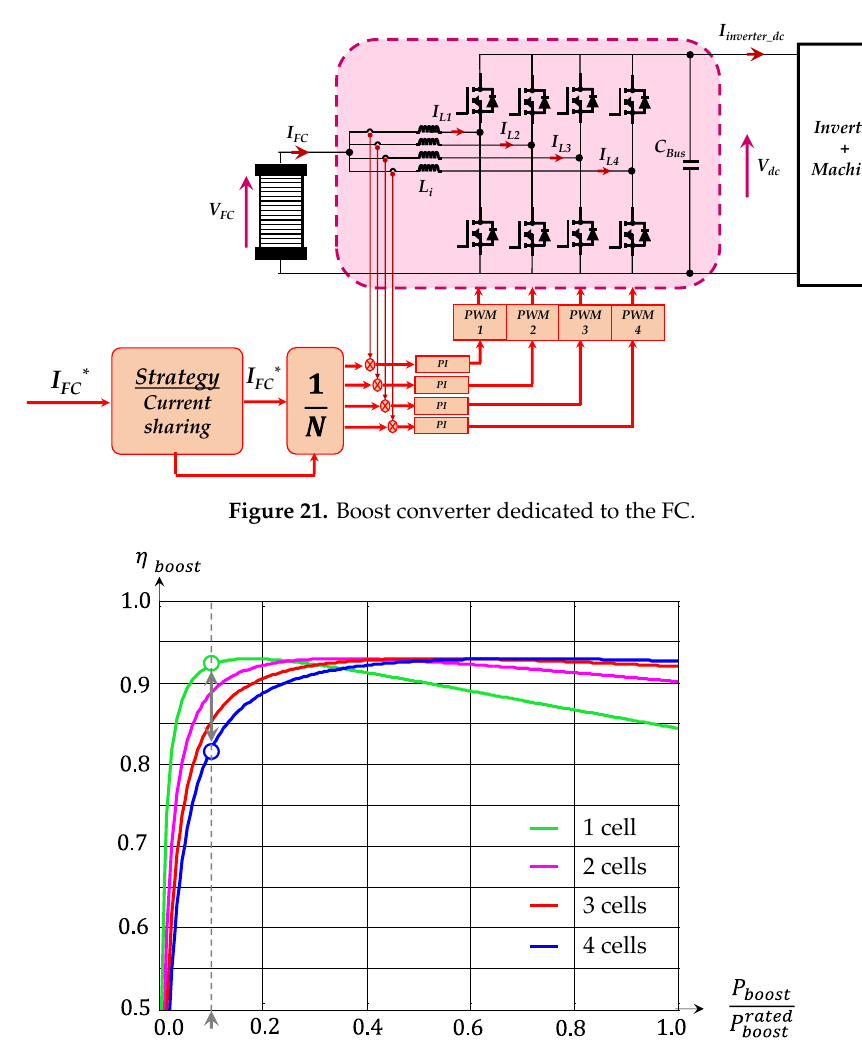
Figure 20. FCV hybrid drive train.